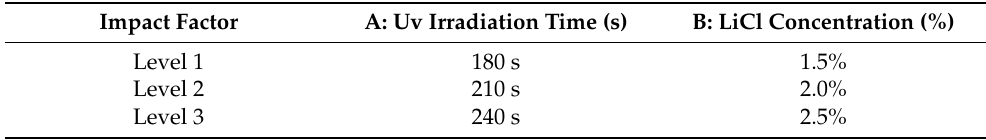
Table 1. Cross experiment table of compound